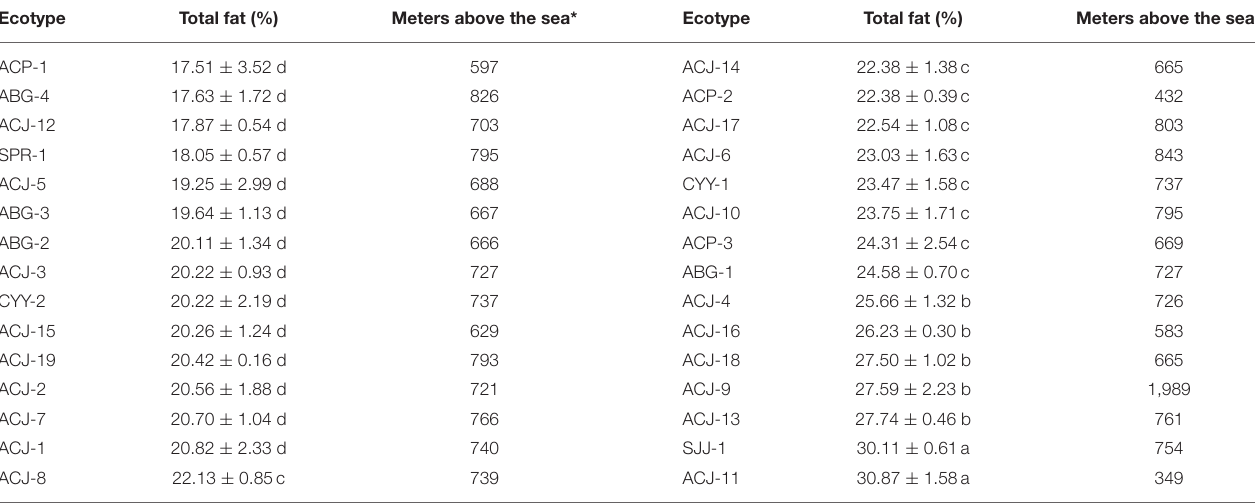
TABLE 1 | Total fat percentage of fine-aroma cocoa ecotypes (means ± standard deviation).